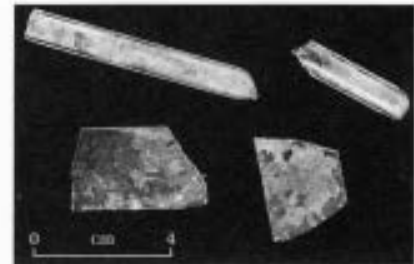
Figure 5 Glass tubes and sheets from the Craven Street site; they closely resemble examples of Hewson's microscope prepa­ rations now in the Hunterian Museum in London.